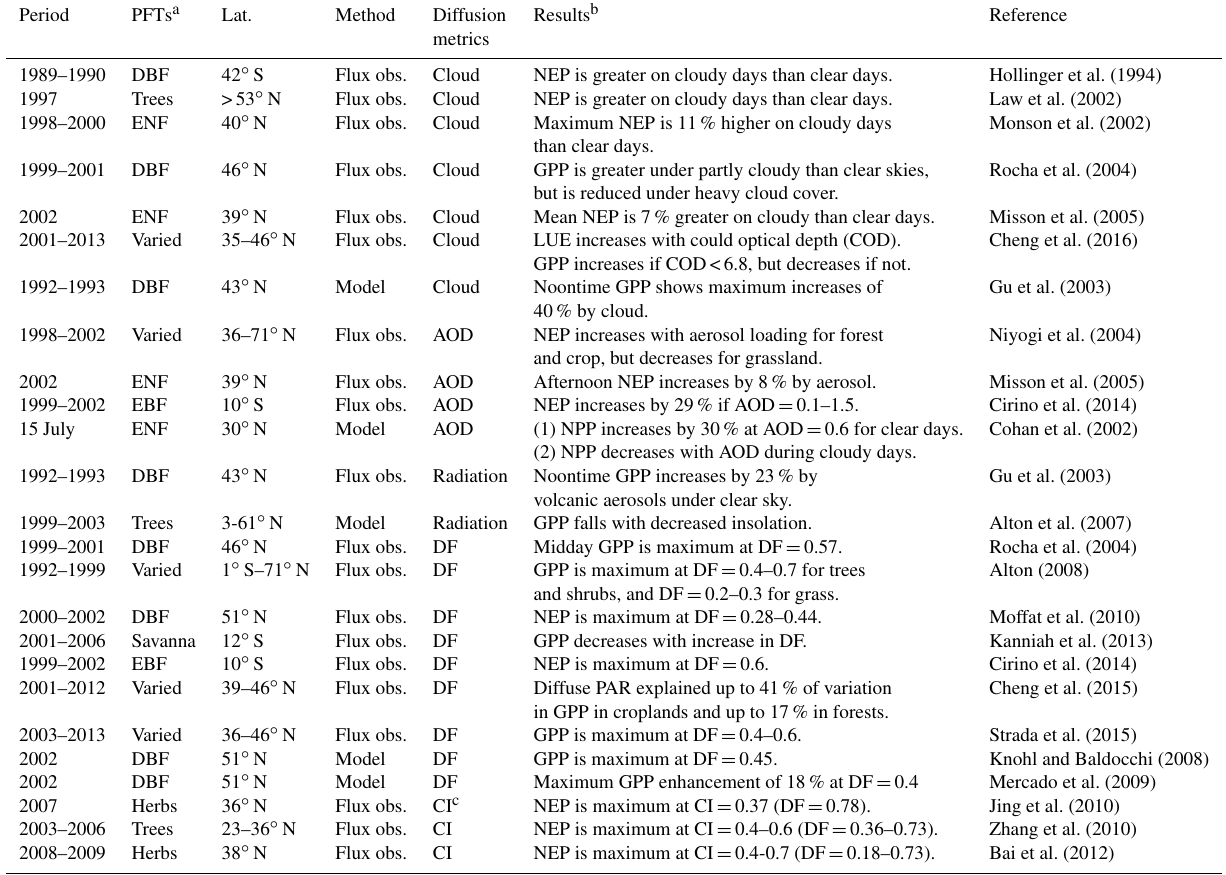
Table 1. Summary of studies about diffuse fertilization effect (DFE).